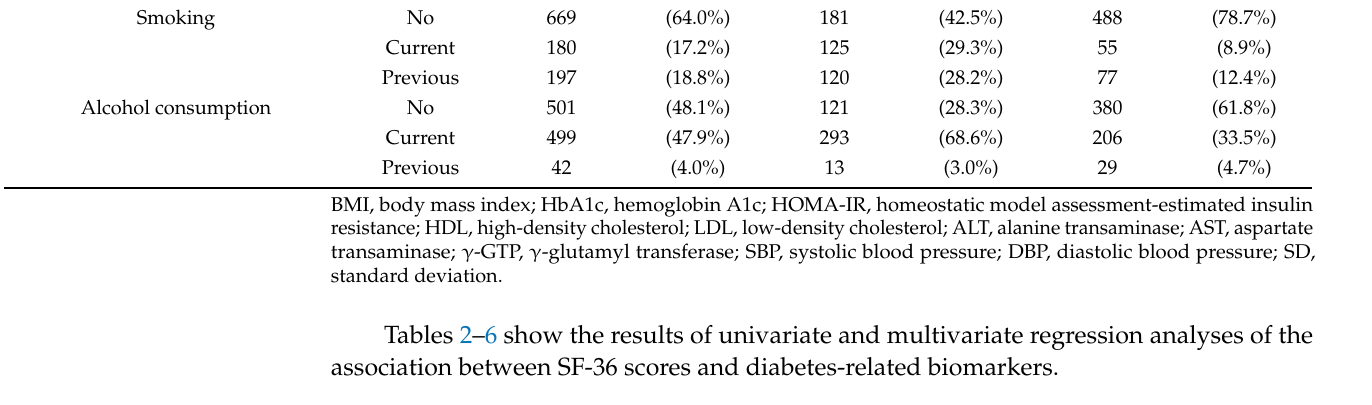
Table 2. Correlation between SF-36 scores and blood glucose levels (mg/dL).